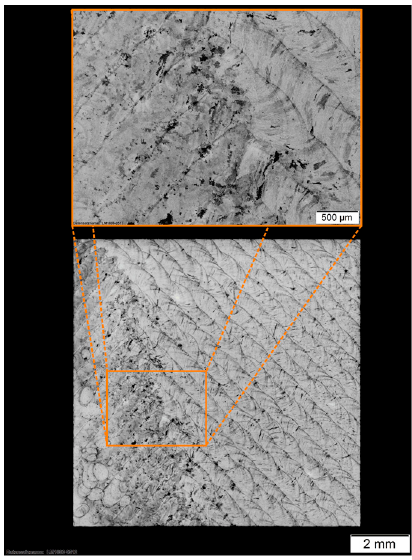
Figure 14. x – y cross section of the generated and heat treated 316L-Si.